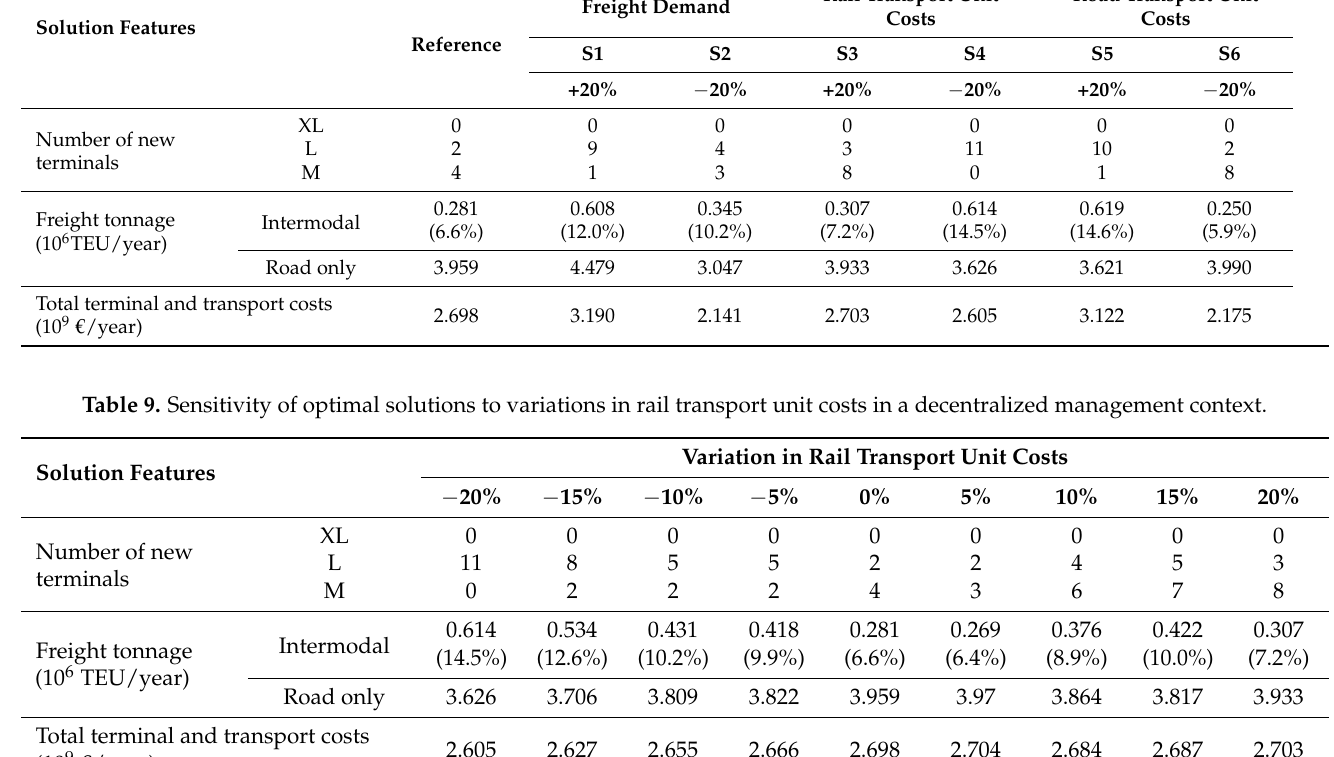
Solution Features